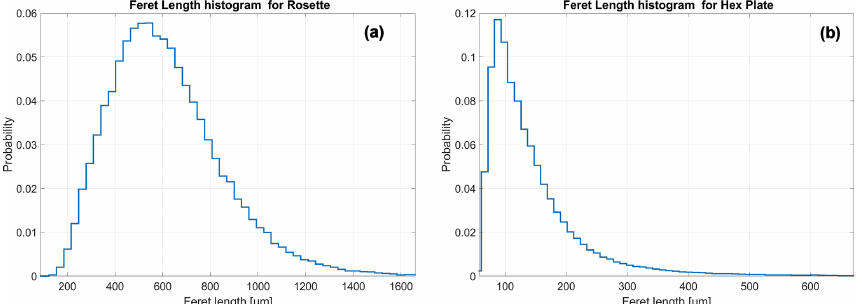
Figure 22. Feret length probability distribution for (a) rosettes and (b) hex. plates. The relevant presence of small plates ( D < 200µm) suggests that sublimation on the DS is not relevant, years